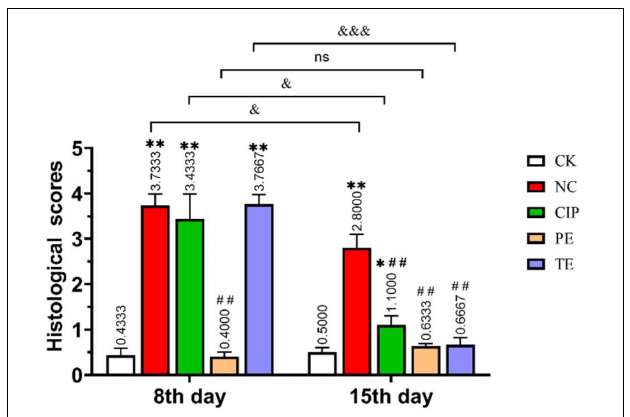
FIGURE 4 | Histological injury score of the ileum in mice. ∗ Represent compare with CK group. ∗ P < 0.05; ∗∗ P < 0.01; # represent compare with NC group. ## P < 0.01; & represent compare with after therapy. & P < 0.05; &&& P <